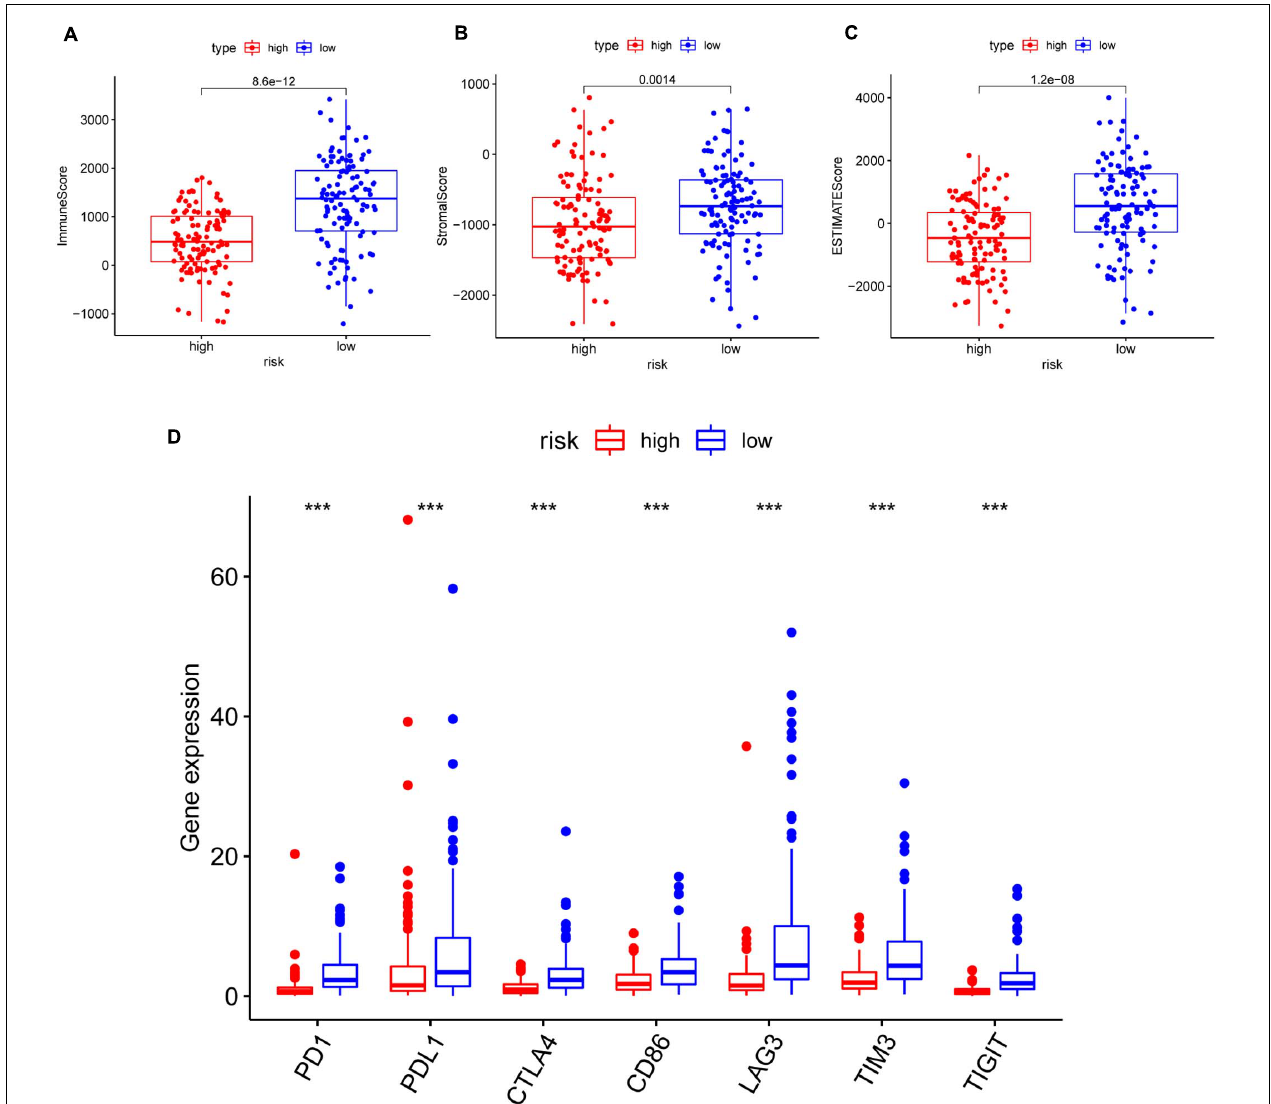
FIGURE 7 | The correlation of risk with the ImmuneScore, StromalScore, ESTIMATEScore, and common inhibitory checkpoint molecules (ICPs). (A–C) The correlation of risk with the ImmuneScore in panel (A) , StromalScore in panel (B) , and ESTIMATEScore in panel (C) ; the Wilcoxon rank-sum test was applied to assess the statistical significance. (D) The correlation between common ICPs and risk groups. The results showed that the expression of ICPs was significantly negatively correlated with the risk group. *** p <